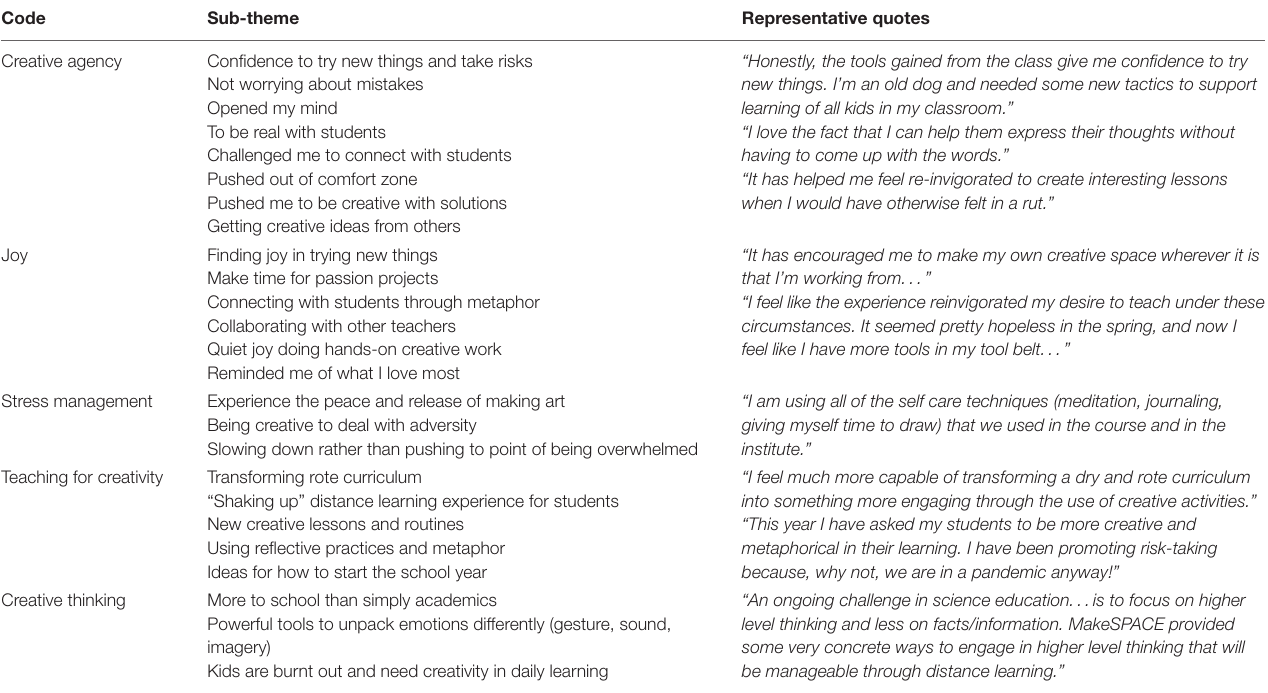
TABLE 4 | Emergent sub-themes about teachers’ preparation from PD